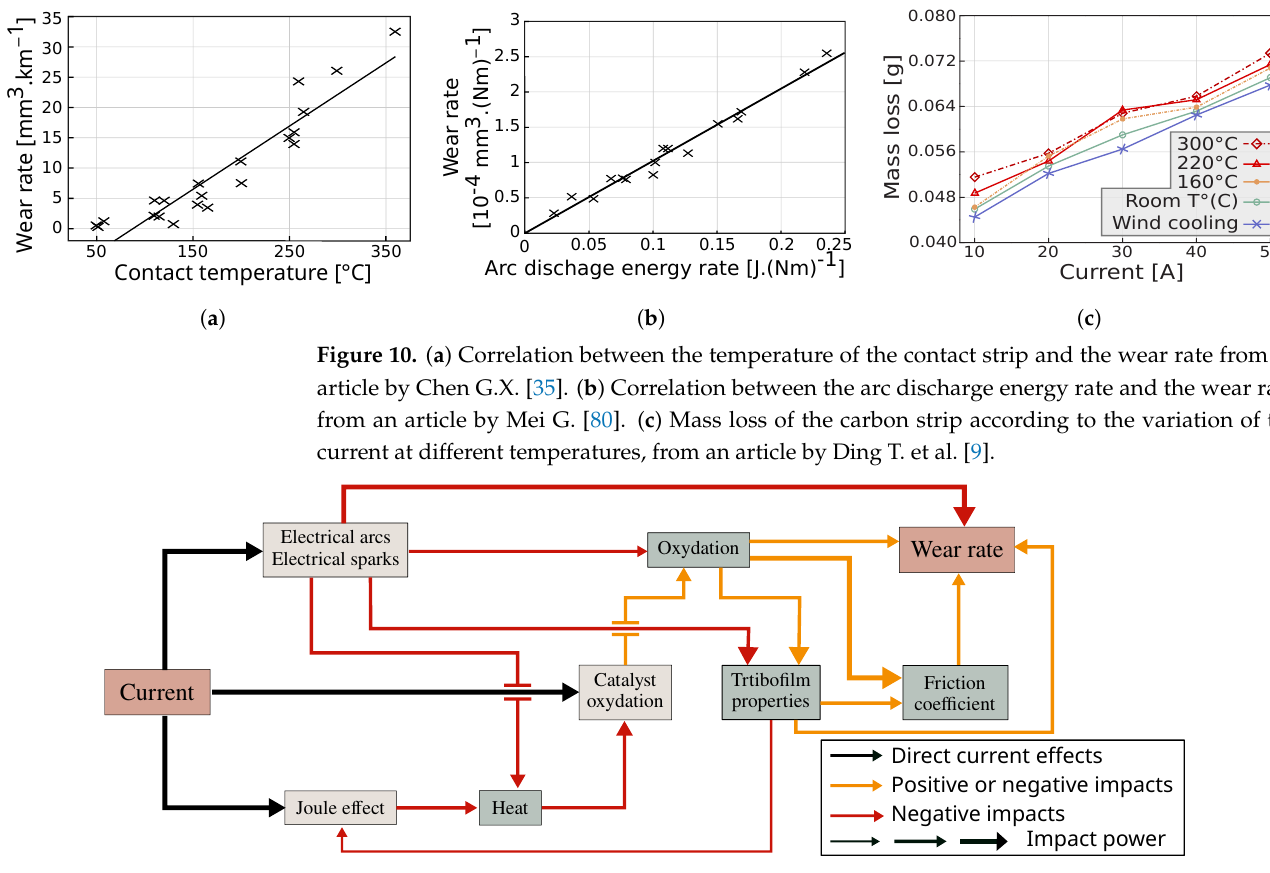
Figure 11. Impacts of the current on the wear of materials found in sliding electrical